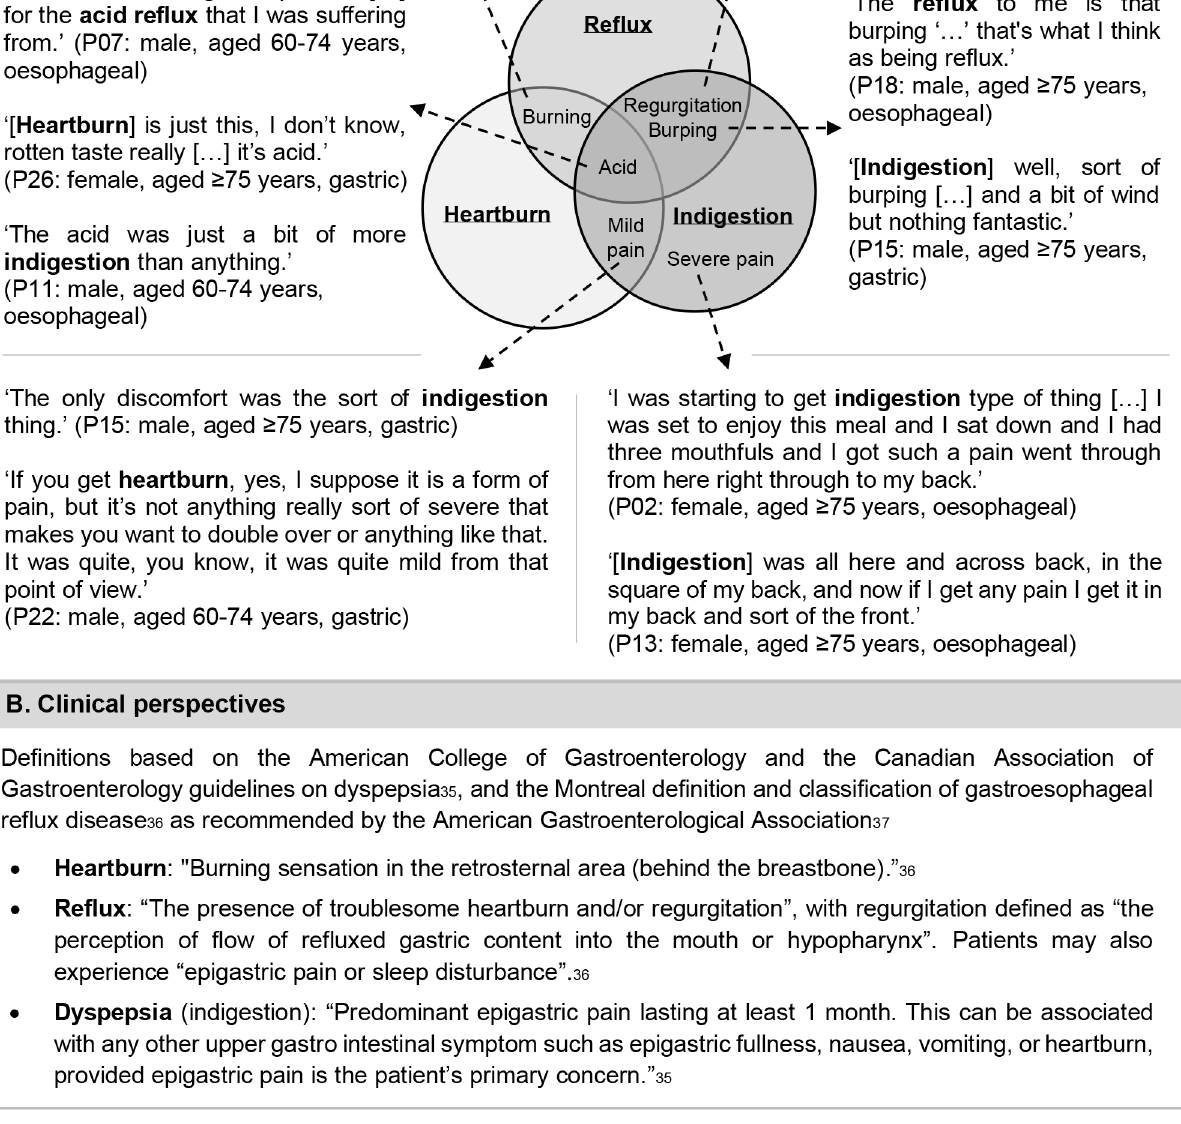
Figure 1 Participant and clinical perspectives of heartburn, reflux, and indigestion.